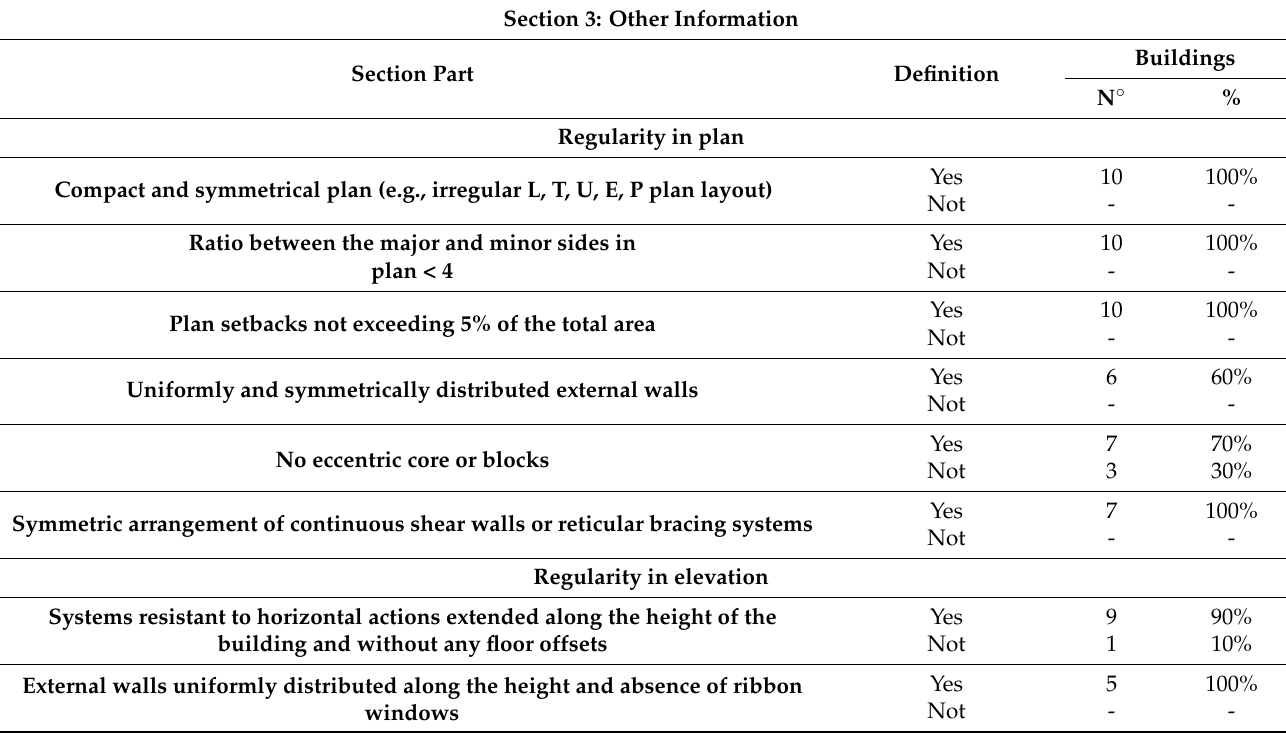
Table 14. 3D 3G CARTIS-Building section. Case studies characterization: Other information—Synoptic